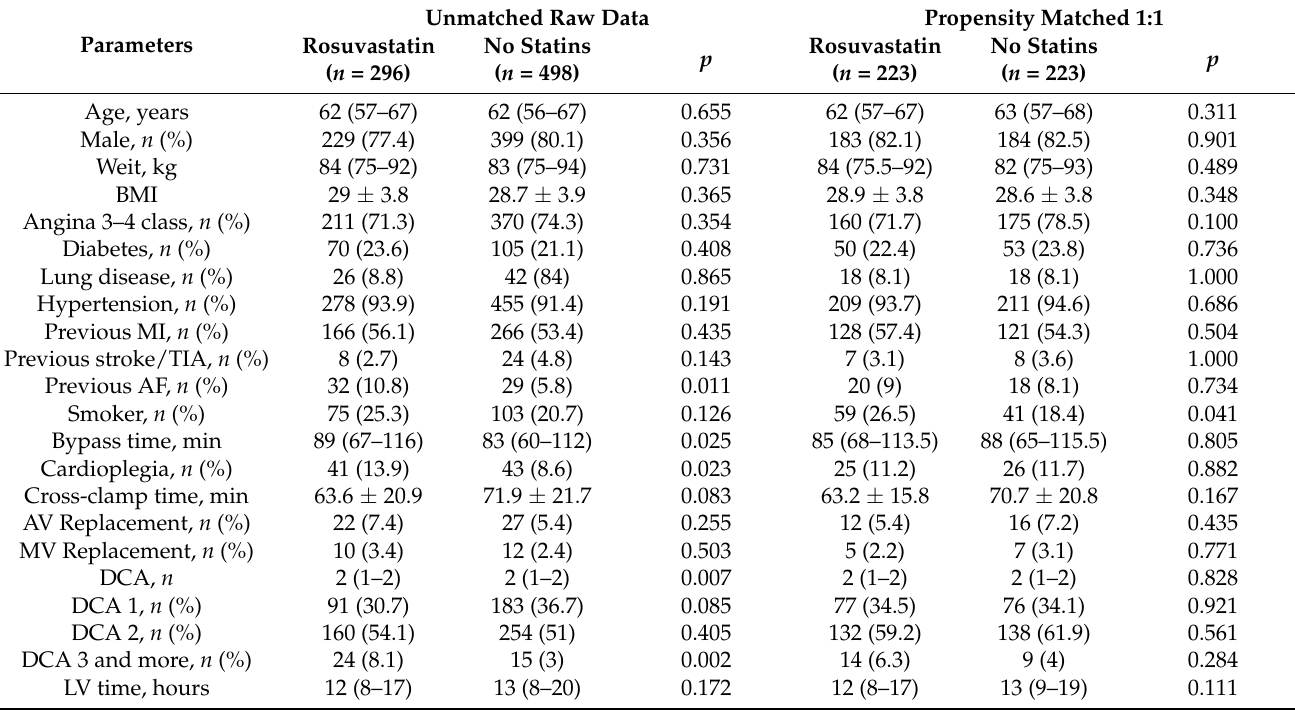
Table 3. Clinical data and operative